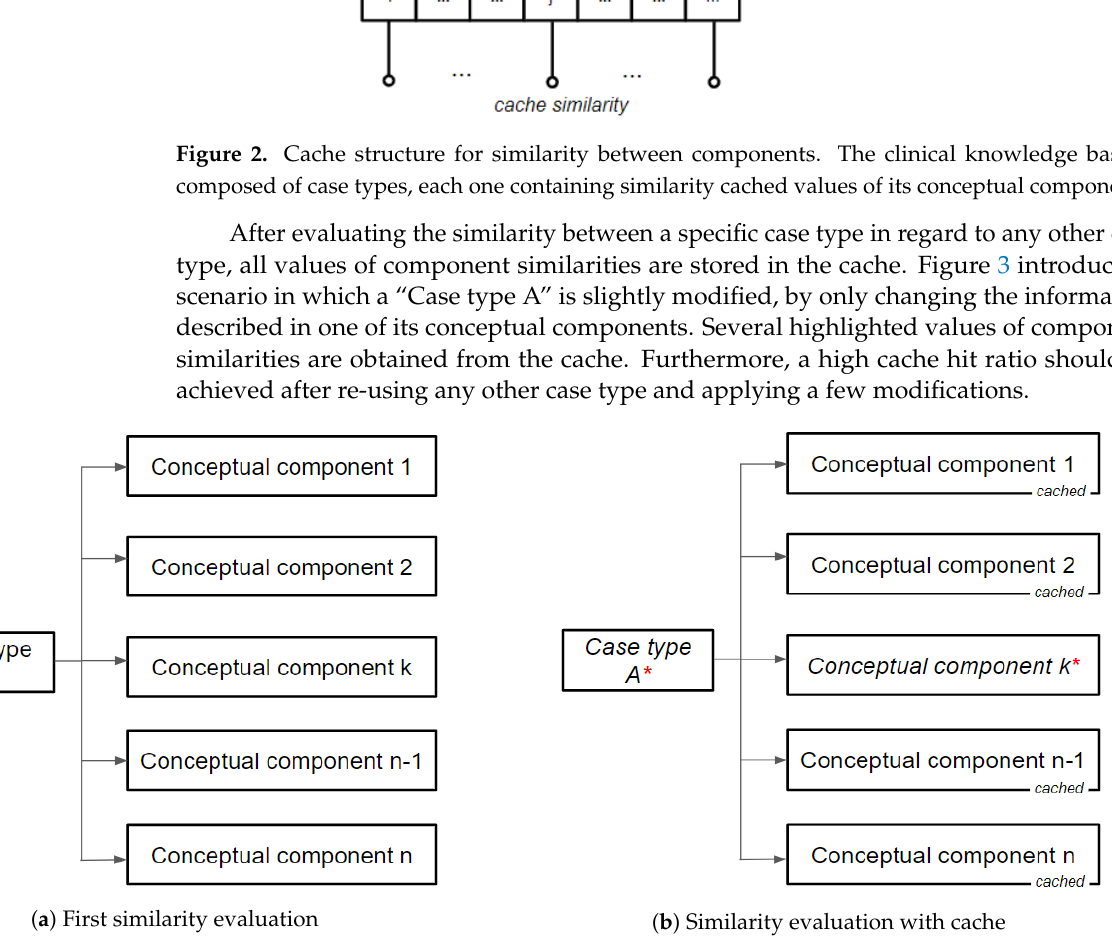
Figure 3. Use of similarity cache